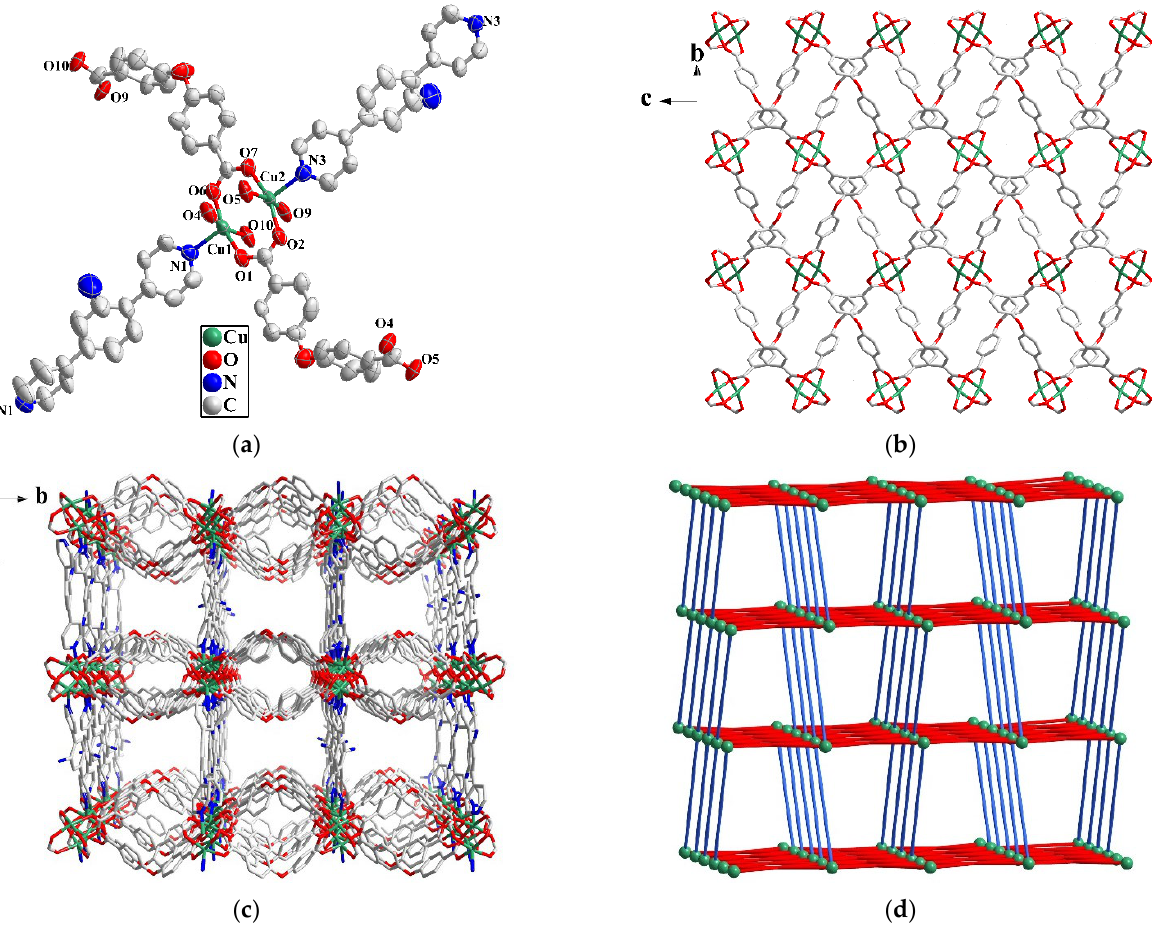
Figure 2. ( a ) The coordination environment of Cu(II) in 2 with 50% thermal ellipsoidal ratio, and the hydrogen atoms are omitted. ( b ) Cu-OBA 2 − 2D network in 2 . ( c ) 3D pillar-layered structure of 2 viewed along c-axis. ( d ) Topology of 2 .